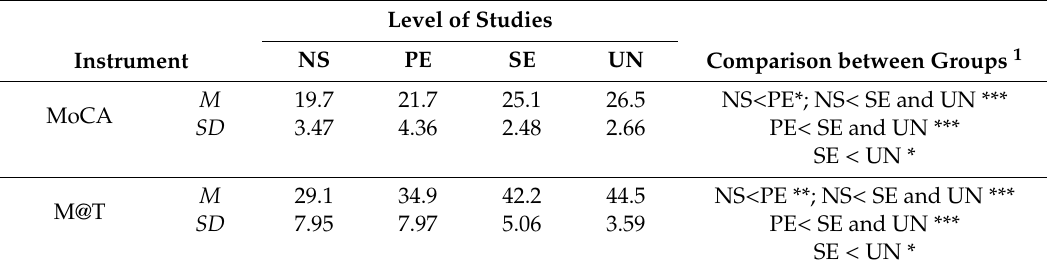
Table 5. ANOVA and descriptive statistics on